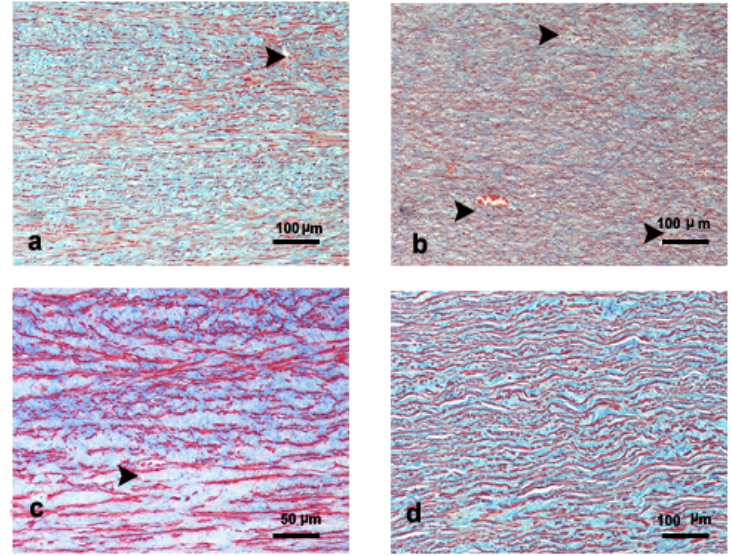
Figure 1. Microscopic findings (trichrome staining) of the ascending aorta in ( a ) Mesoplodon densirostris adult male, ( b ) Globicephala macrorhynchus adult male, ( c ) Kogia breviceps adult male, and ( d ) Physeter macrocephalus subadult male. Elastic fibers; dark orange in ( a , b ) dark red in ( c ). smcs; light orange in ( a , b ), light red in ( c ). Connective tissue; blue in ( c , d ), and green-blue in ( a ). Some small vessels are present in the wall (arrowhead). The elastic laminas are located circular and longitudinally.